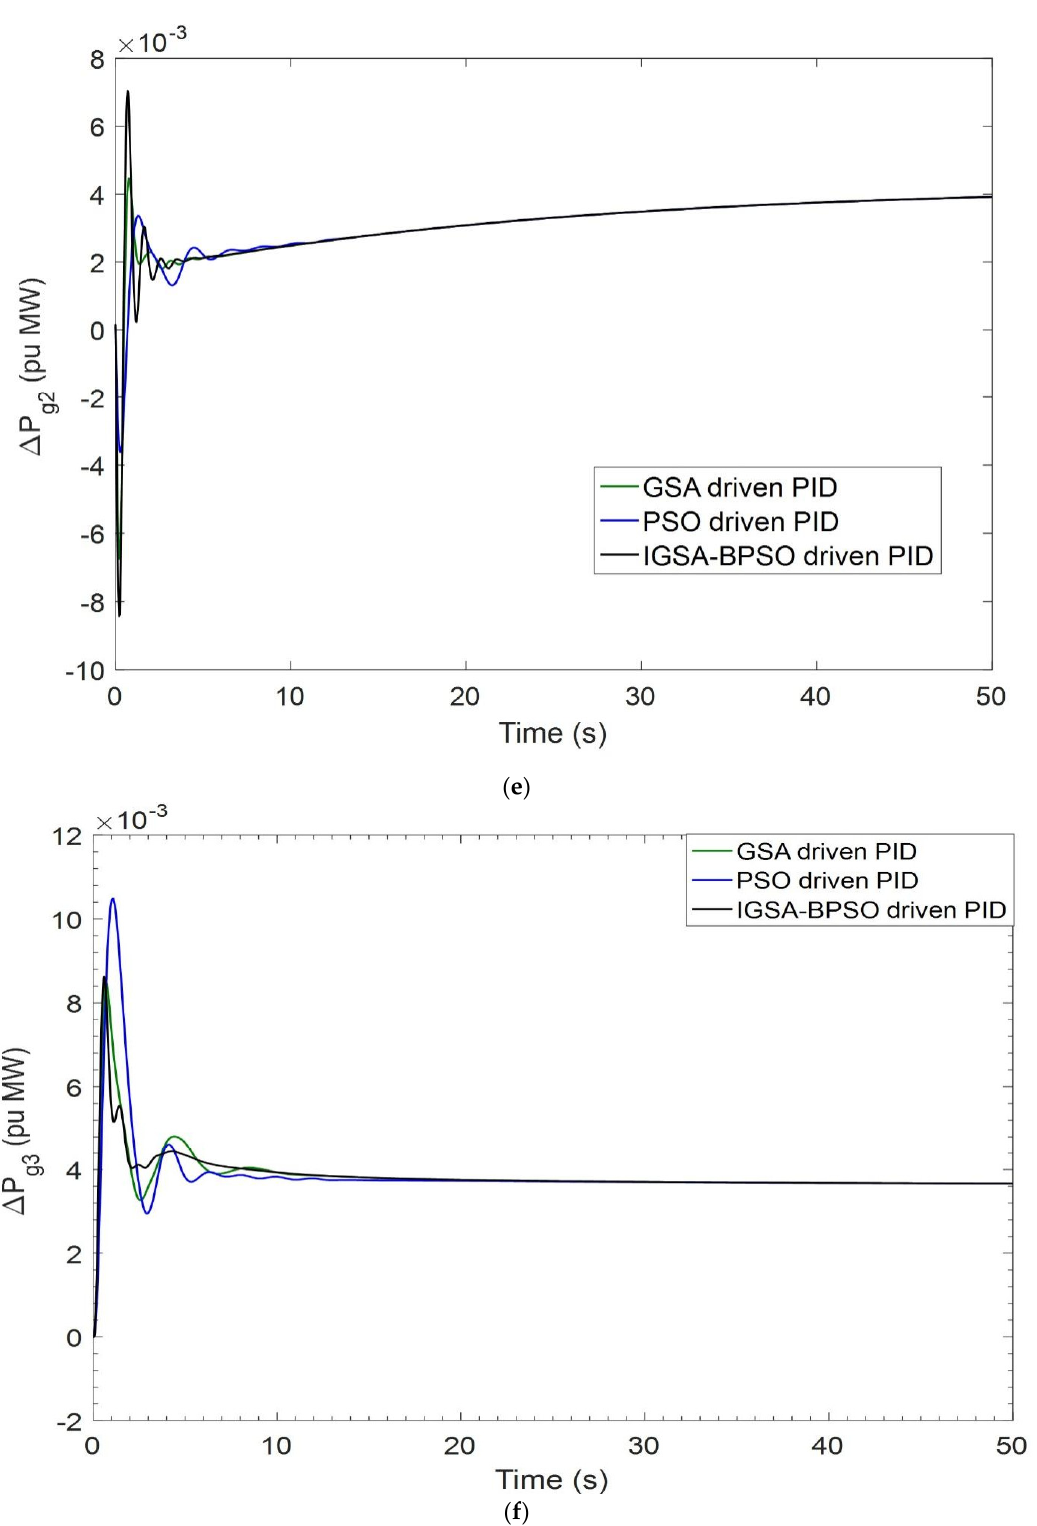
Figure 7. ( a ) Dynamic response of Δ F 1 for CVT case; ( b ) dynamic response of Δ F 2 for CVT case; ( c ) dynamic response of Δ P tie for BBT case; ( d ) perturbation response of GENCO–1 for CVT case; ( e ) perturbation response of GENCO-2 for CVT case; ( f ) perturbation response of GENCO–3 for CVT case.